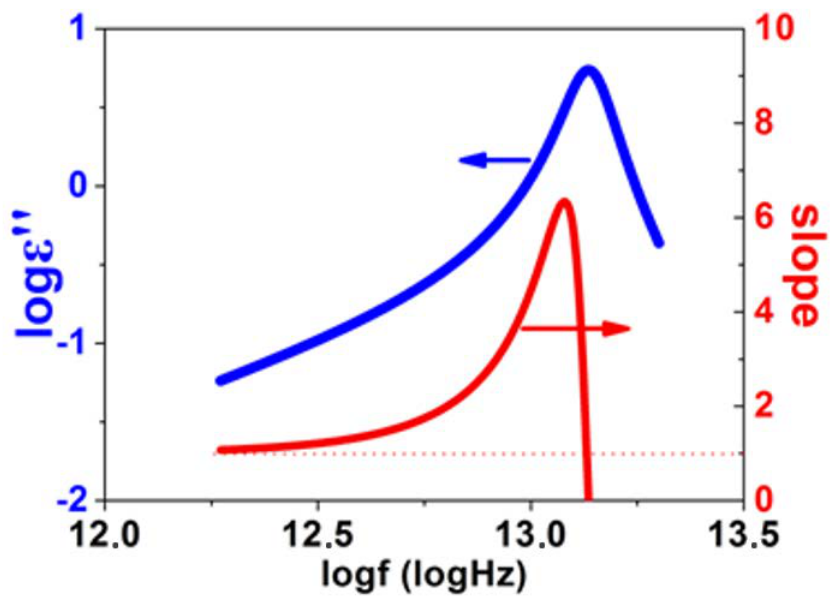
Figure 4. The blue line (left axis) shows the frequency dependence of the imaginary part of com- plex dielectric constant according Equation (9) with parameter values γ /2 π = 3.79 × 10 12 (Hz), A /(2 π ) 2 = 2.84 × 10 26 (Hz 2 ) and ω o /2 π = 1.37 × 10 13 (Hz) (higher frequencies vibration mode of Figure 3). The red line (right axis) shows the corresponding slope of log ε (cid:48)(cid:48) ( log f )